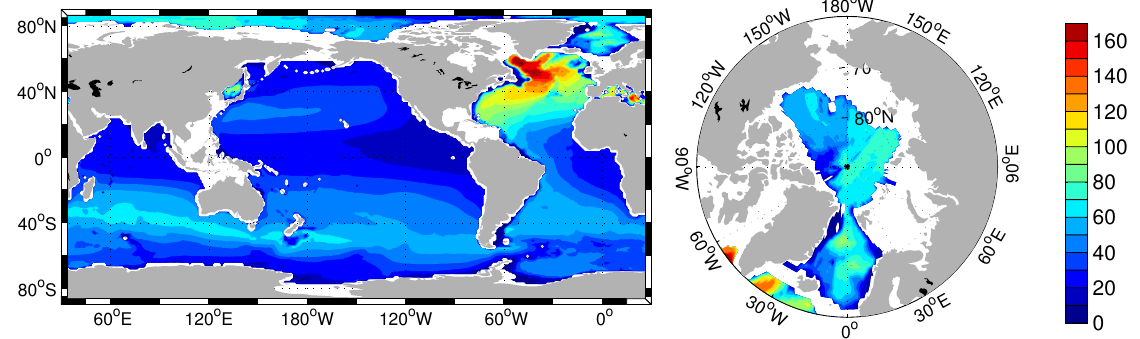
Fig. 1. Compilation of 2010 column inventories (mol m − 2 ) of anthropogenic CO 2 : the global ocean excluding the marginal seas (Khatiwala et al., 2009) 150 ± 26 PgC; Arctic Ocean (Tanhua et al., 2009) 2.7– 3.5 PgC; the Nordic Seas (Olsen et al., 2010) 1.0–1.6 PgC; the Mediterranean Sea (Schneider et al., 2010) 1.6–2.5 PgC; the East Sea (Sea of Japan) (Park et al., 2006) 0.40 ± 0.06 PgC.